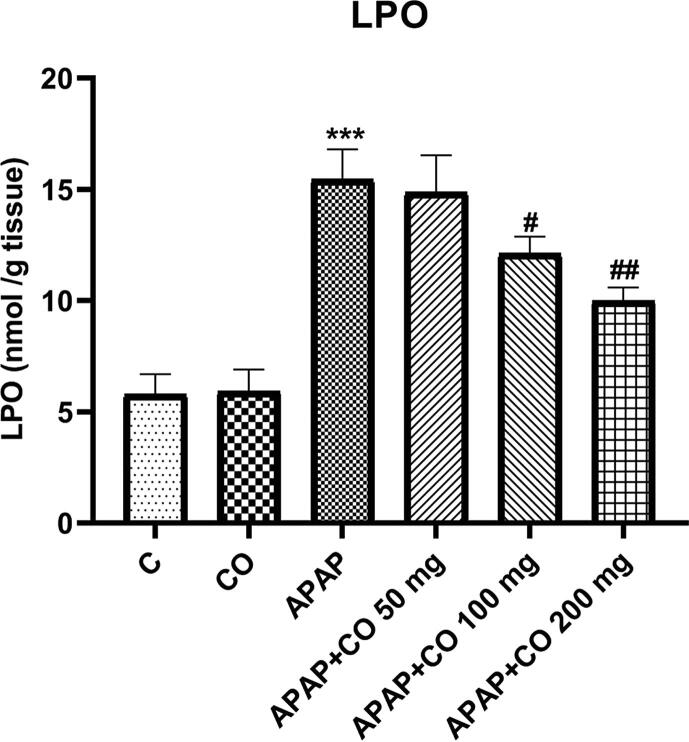
Effect of CO on kidney tissue levels of LPO in nephrotoxicity induced by APAP. Data presented as Mean ± SEM (n = 6). ***p < 0.001 designates significant difference between only APAP with control group, ##p < 0.01 and #p < 0.05 shows significant difference from APAP untreated group (VEH).